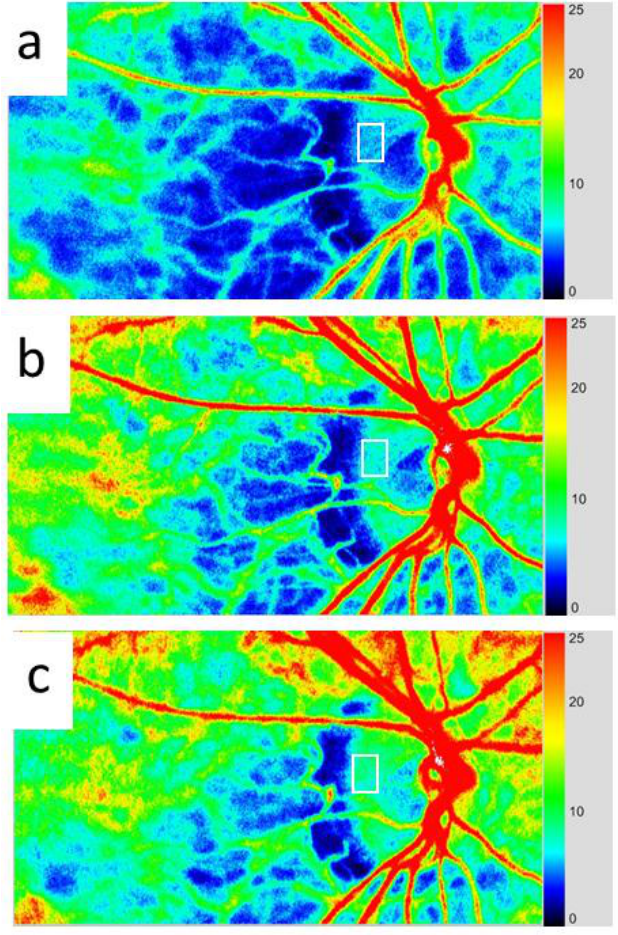
Figure 9. A representative change of the ONH blood flow in NTG patient induced by taking a calcium antagonist, nilvadipine: pretreatment ( a ), 1 month ( b ) and 6 months ( c ) after the treatment started (MBR of the rectangular region at the rim was 5.4, 6.8, and 8.1,